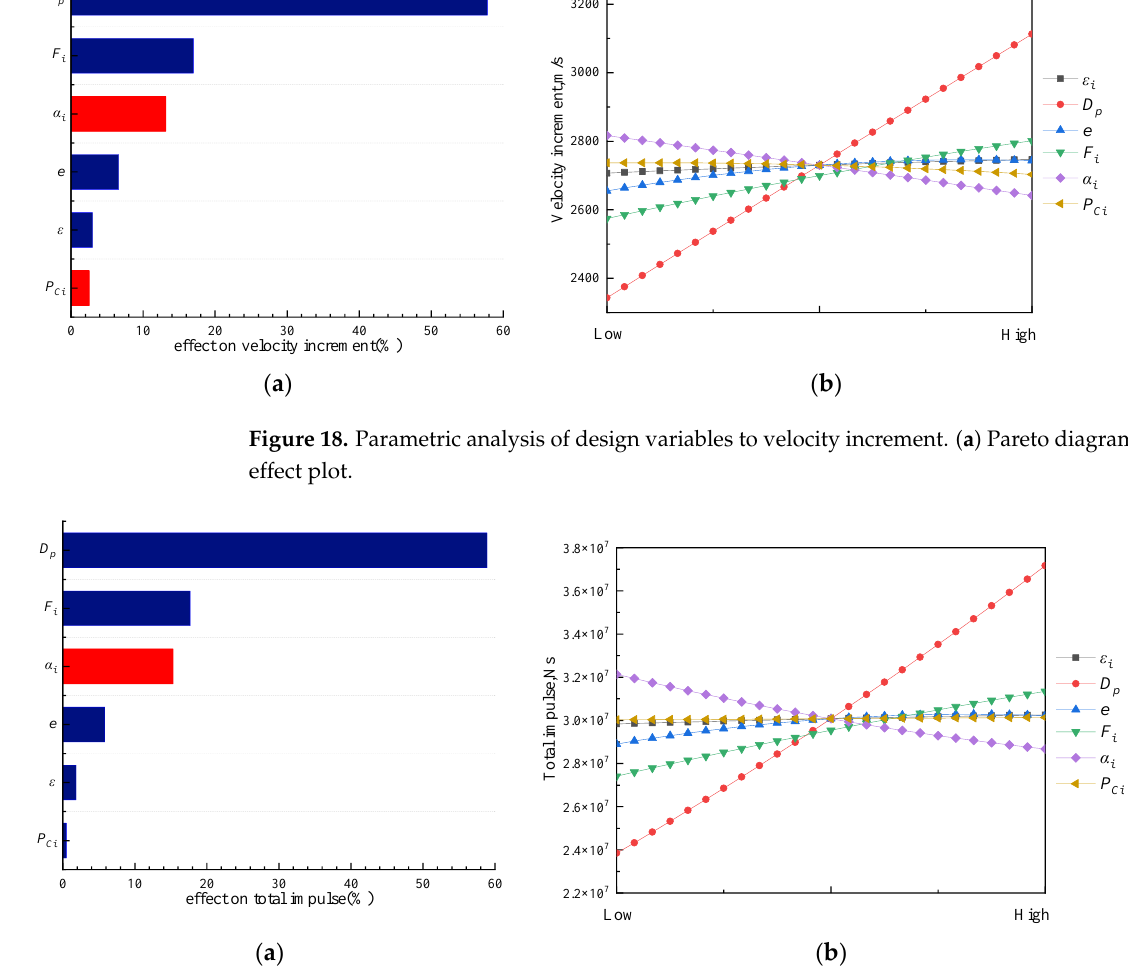
( b ) Figure 20. Parametric analysis of design variables to the motor length. ( a ) Pareto diagram; ( b ) main effect plot. Each design parameter has a similar impact on mass and cost, among which the grain diameter D p , initial oxidizer-to-fuel ratio